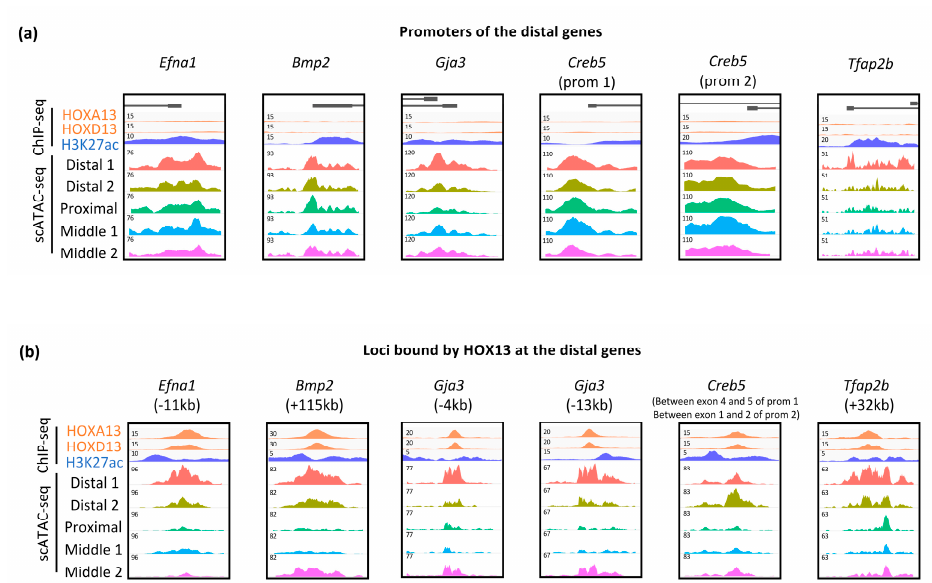
Figure 5. HOX13 binding at regulatory loci of distal genes correlates with distal-specific chromatin opening. ( a , b ) Genome views of HOXA13, HOXD13 and H3K27ac ChIP-seq (IGV) as well as scATAC-seq signals (Signac) at distal genes promoters ( a ) and at their previously identified or potential distal limb enhancers ( b ) in E11.5 mouse forelimb buds. Prom: